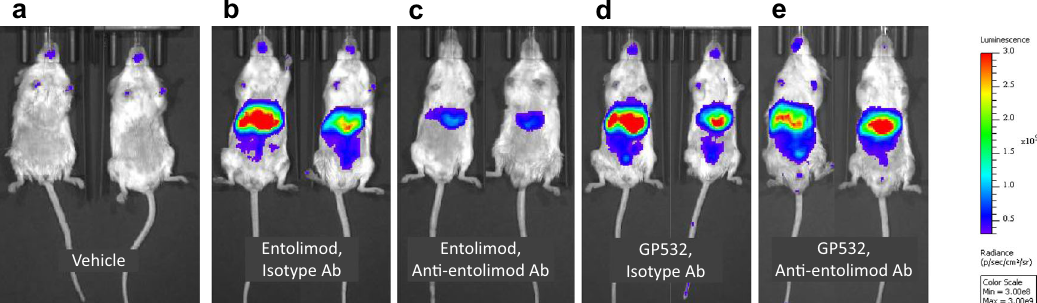
Fig. 8 Effect of entolimod and GP532 on in vivo NF- κ B signaling in reporter mice in the absence or presence of transfused human entolimod-reactive neutralizing antisera. Transgenic NF- κ B-luciferase reporter mice were transfused with neutralizing ( “ anti-entolimod ” , panels c , e ) or non-neutralizing ( “ isotype ” control, panels b , d ) human serum followed 2.5 h later by s.c. injection of 1 μ g/mouse entolimod (panels b , c ) or GP532 (panels d , e ). Live imaging was performed 3 h post-injection. The intensity of the luminescence signal is indicated by color as shown by the bar to the right of the panels. Control mice were injected s.c. with vehicle only (no transfusion, panel a ). Images of two representative mice from each group are shown ( n = 3 – 4 mice/